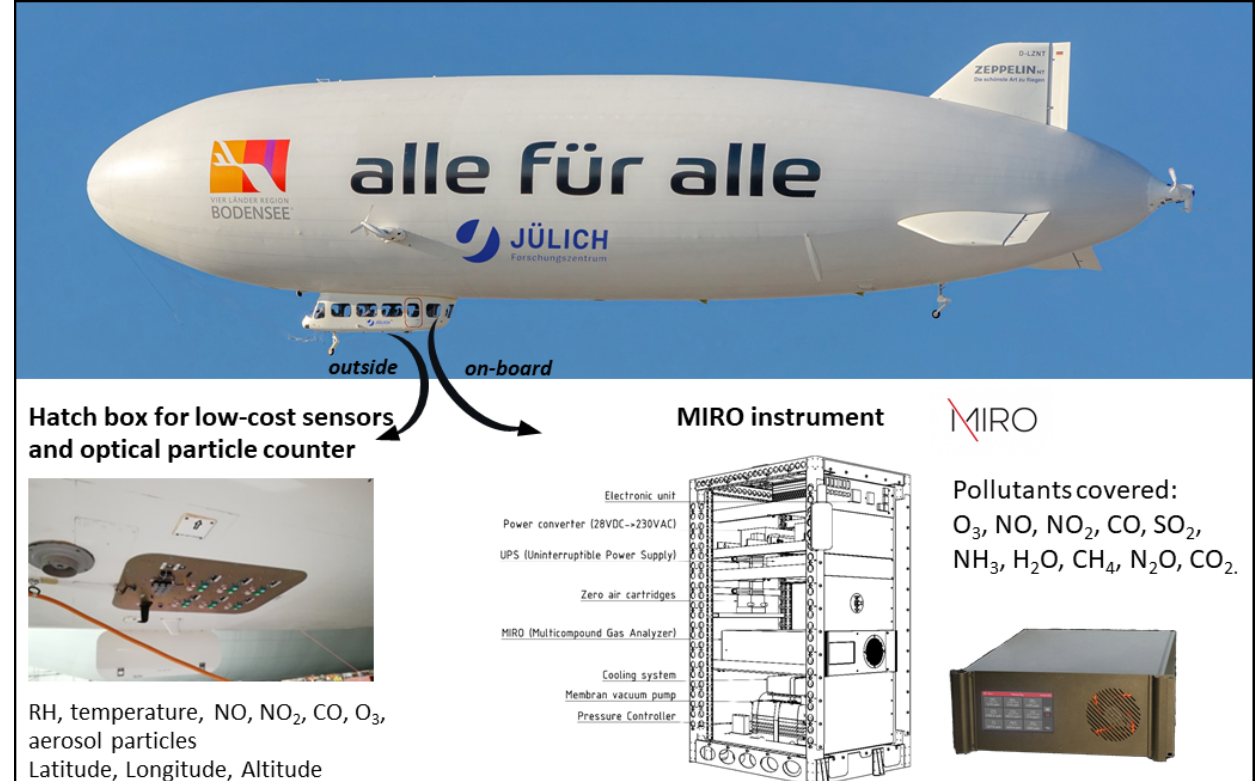
Figure 2. Instrumentation onboard the Zeppelin aircraft (Zeppelin picture by Michael